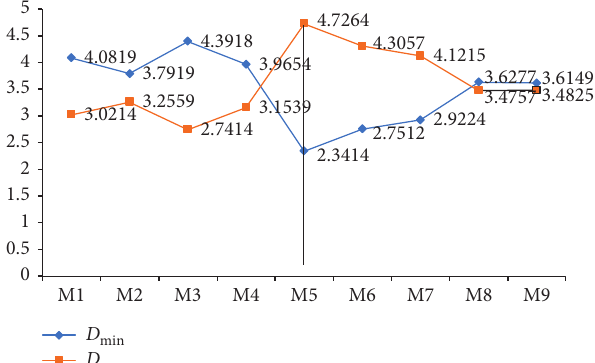
Figure 7: Visualization of the evaluation of module innovation resources at τ � 0.5.